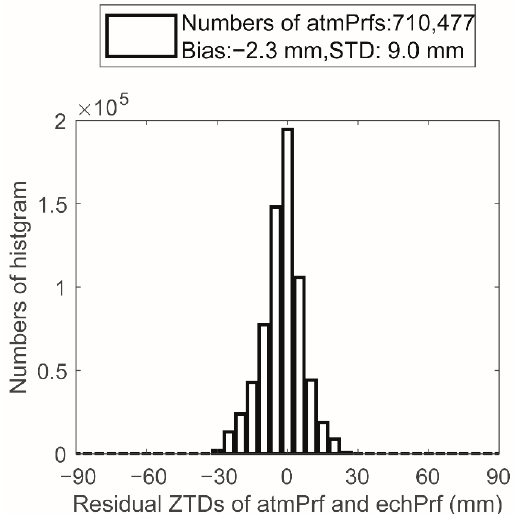
Figure 1. ZTD differences between matched atmPrf and echPrf in 2008.